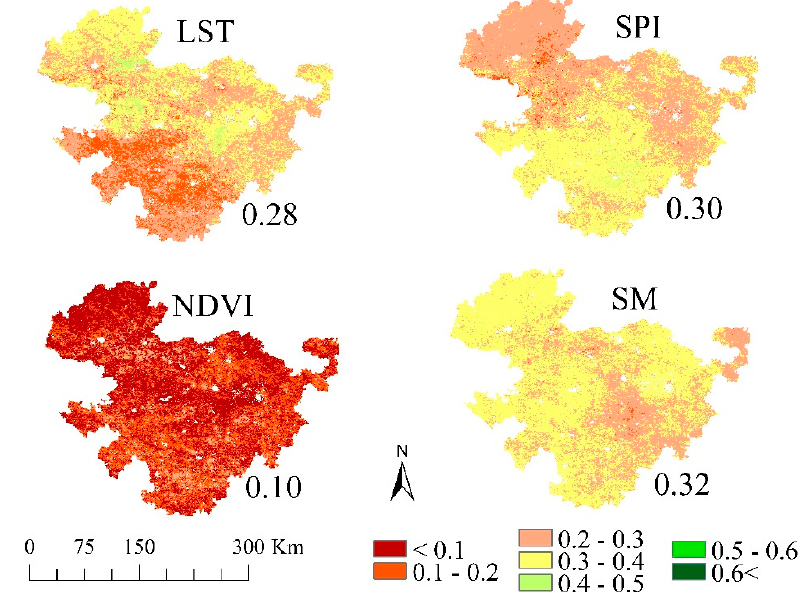
Figure A3. The sample (June month) spatial pattern of percent contribution of land surface temperature (LST), SPI, normalized di ff erence vegetation index (NDVI), and soil moisture (SM) over the Marathwada.